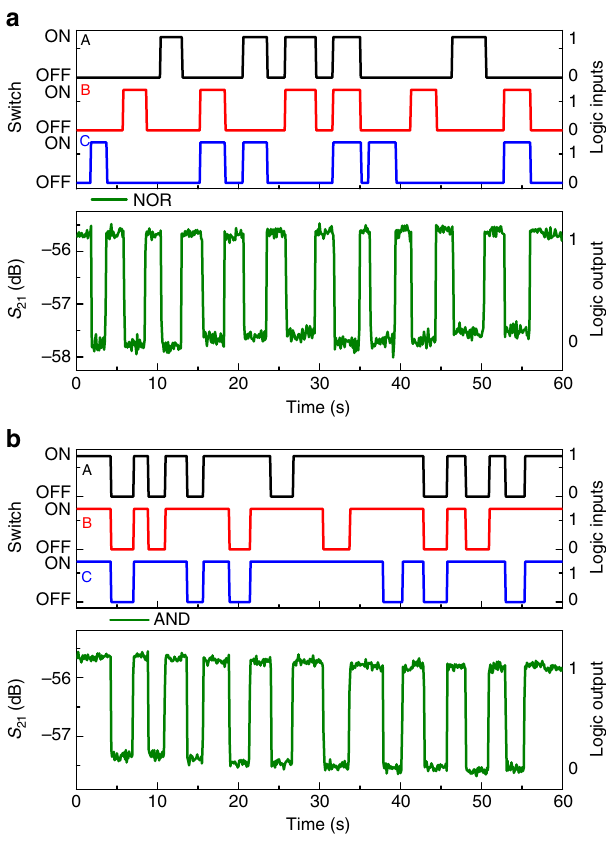
Figure 9 | Demonstration of 3-bit logic gates. ( a ) Demonstration of 3-bit NOR logic operation when the operating frequency is chosen at 119.022kHz. Three input signals, A, B, and C are shown in black, red, and blue, respectively, where the switch OFF/ON corresponds to 0/1 logic input conditions. S 21 transmission signal in green corresponds to the logic output and fulfills the NOR truth table. ( b ) Demonstration of 3-bit AND logic operation when the operation frequency is chosen at 132.105kHz. Three input signals, A, B, and C are shown in black, red, and blue, respectively, where the switch OFF/ON corresponds to 0/1 logic input conditions. S 21 transmission signal in green corresponds to the logic output and fulfills the AND truth